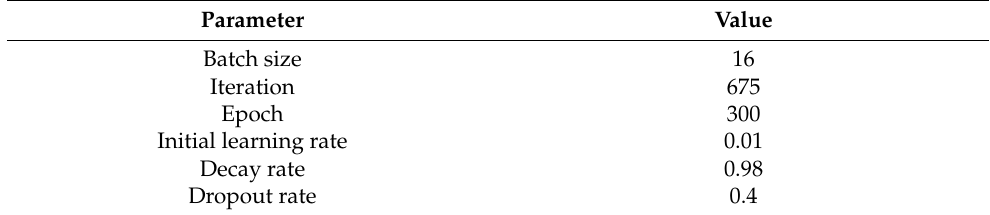
Table 2. Parameters of the training